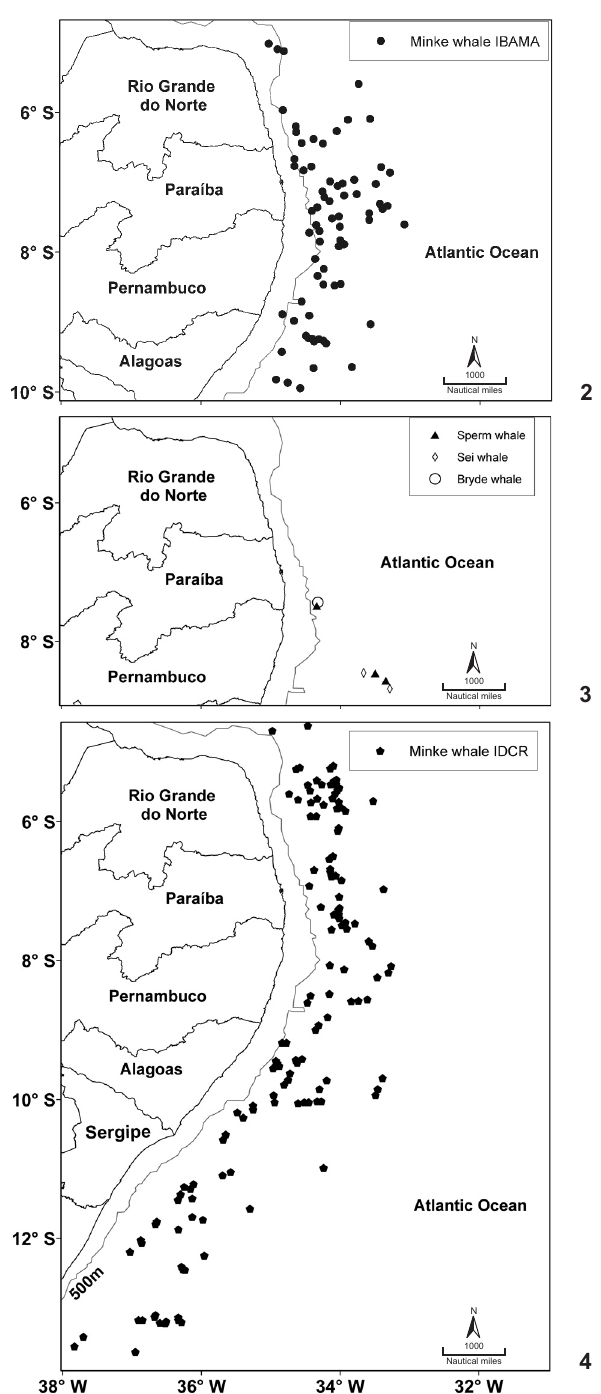
Figures 2-4. Distribution of large whales off northeastern Brazil between 1998 and 2001 by the Minke Whale Project (IBAMA) (2- 3) and data of IDCR cruise in 1981 (4). The gray line following the coast line is the 500m